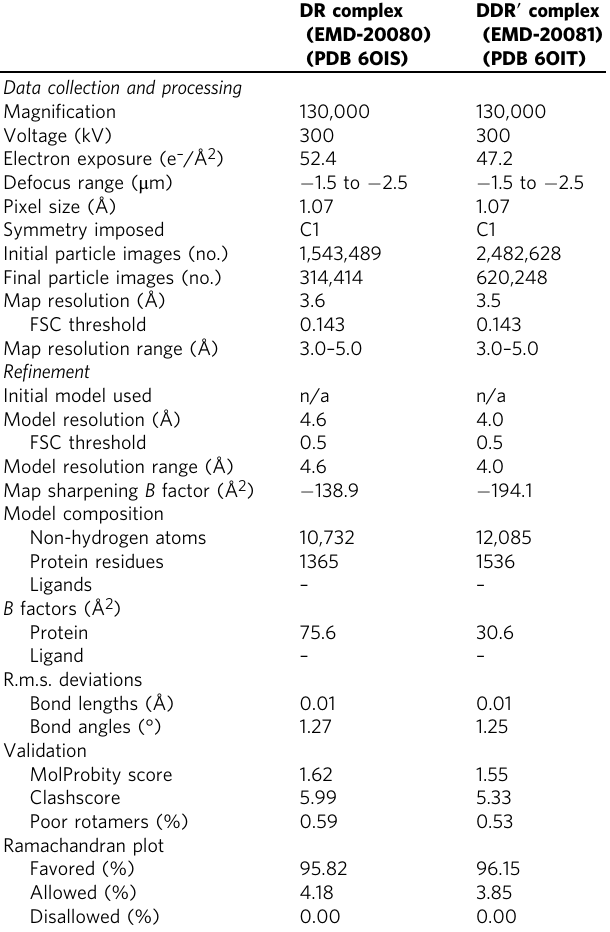
Table 1 CryoEM data collection, re fi nement and validation